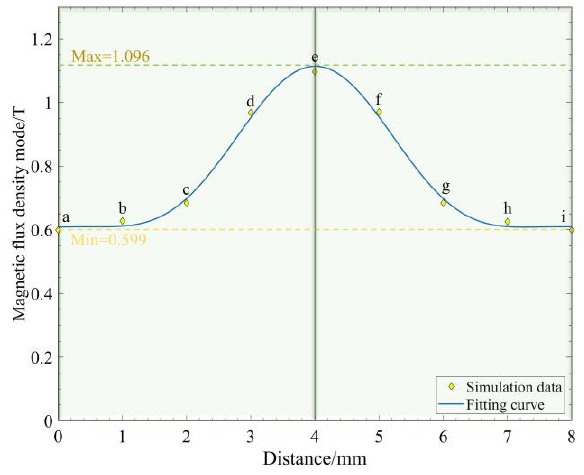
Figure 9. Magnetic field strength curves for Halbach array and MRG layer optimal working area.